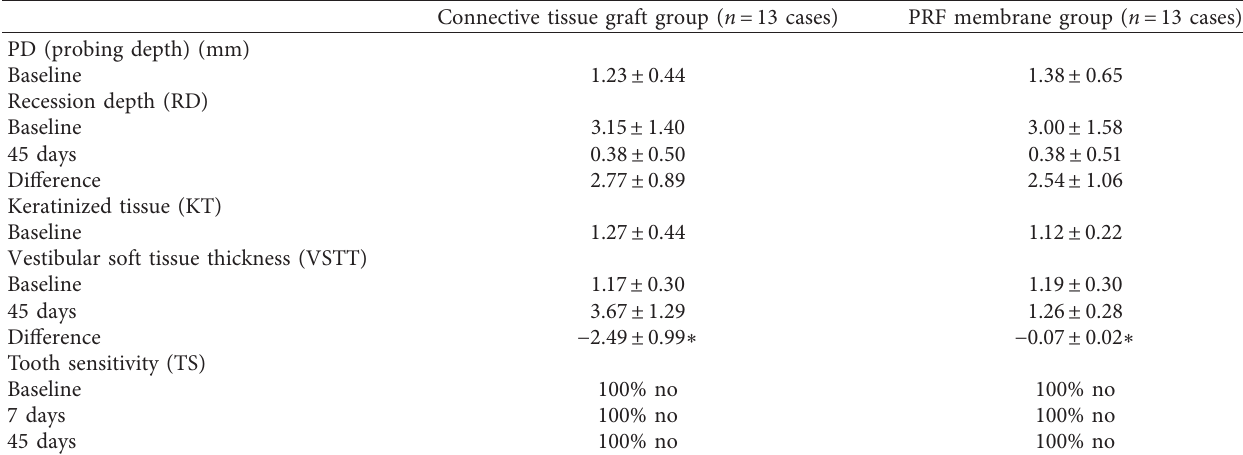
Figure 1: PRF collection. A blood sample was obtained in 10ml plastic tubes without anticoagulant and no activator. Immediately, the tubes were centrifugated at 3000 rpm for 10minutes (Scilogex DM1536). The fibrin clot was removed from the tube and separated by mi- crosurgical scissors. The PRF membrane was pressed into a calibrated metal box that forms membranes at a constant thickness of 1mm. Two membranes of PRF were superimposed and immediately taken into the surgical site. Table 1: Descriptive data for clinical